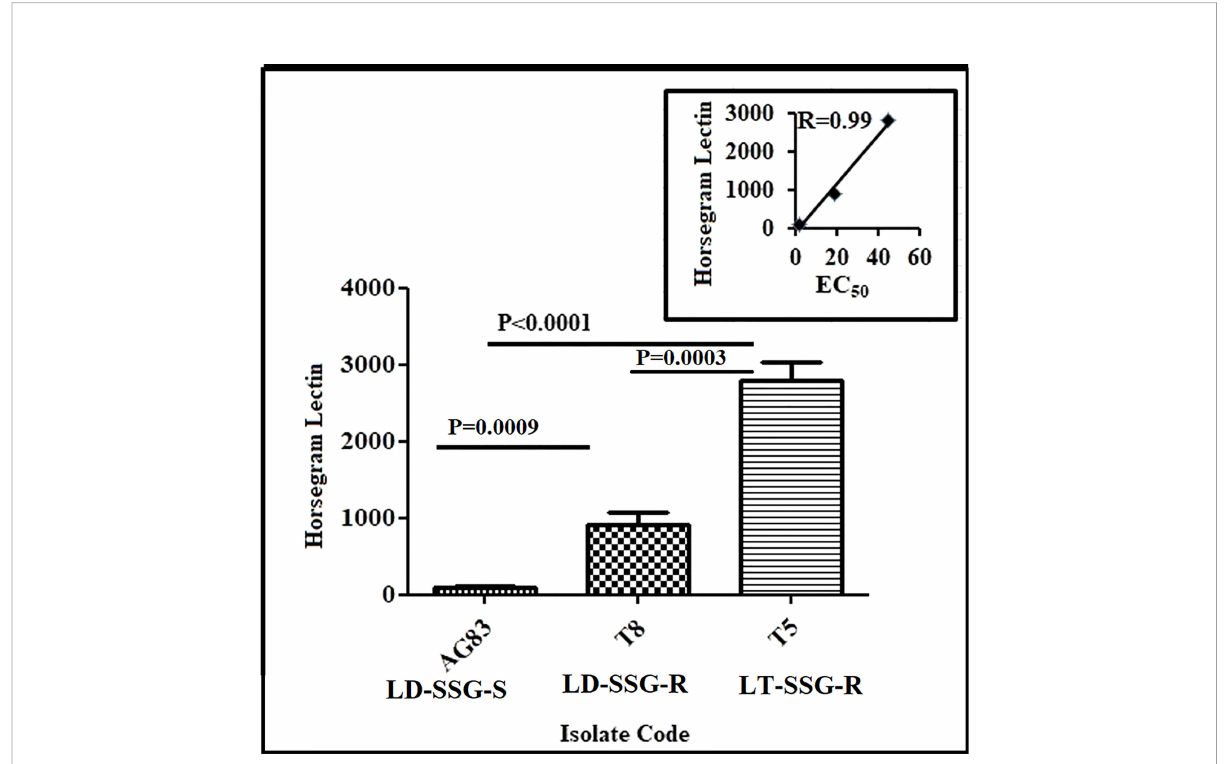
FIGURE 2 Flow cytometric analysis of the differential expressions of terminal N-acetyl- D-galactosaminyl residue in promastigotes of SSG-R (T5-LT-SSG-R and T8-LD-SSG-R) and SSG-S (AG83-LD-SSG-S) fi eld isolates. The plot shows the binding of FITC-labeled horsegram lectin ( Dolichos bi fl orus ) in SSG-R and SSG-S isolates. Each scatter plot in the inset represents the correlation between the EC 50 of the isolates with the presence of surface sugar